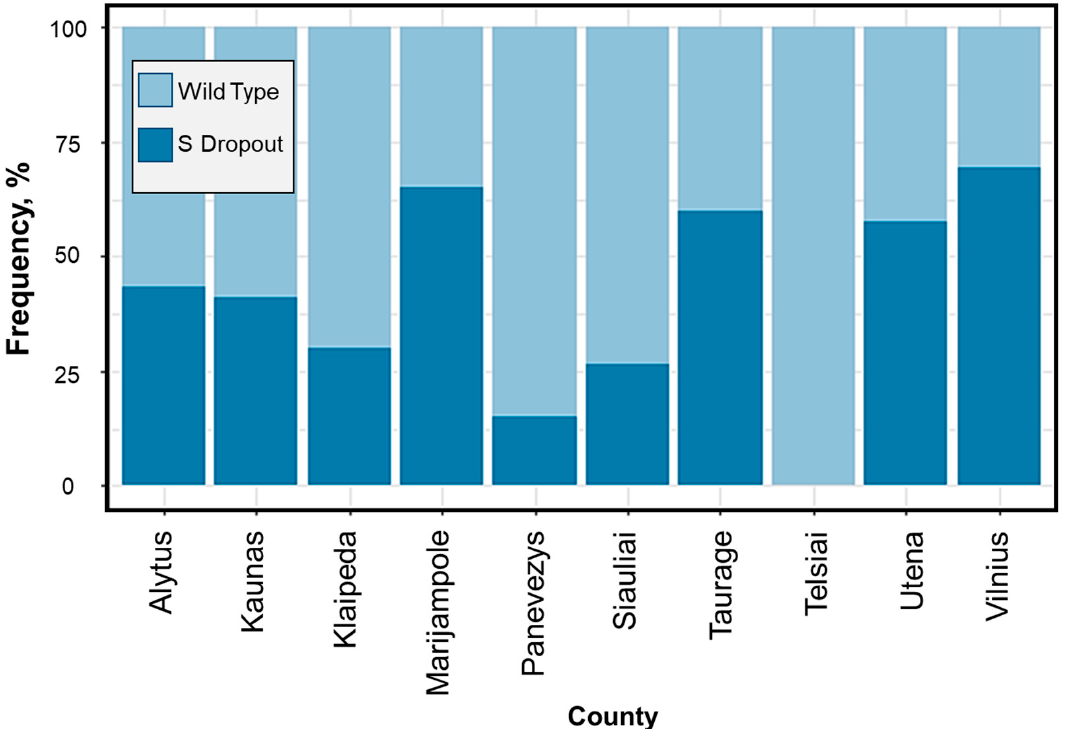
Figure A3. Marijampole, Taurage, Utena, and Vilnius counties S-dropout accounted for the largest spread >50%; in Alytus and Kaunas counties, S-dropout samples accounted for about 40% of the samples, Kaipedos about 30%, Siauliai 25%, and Panevezys about 12%; in Telsiai county, no S-dropout samples were detected (n = 939).